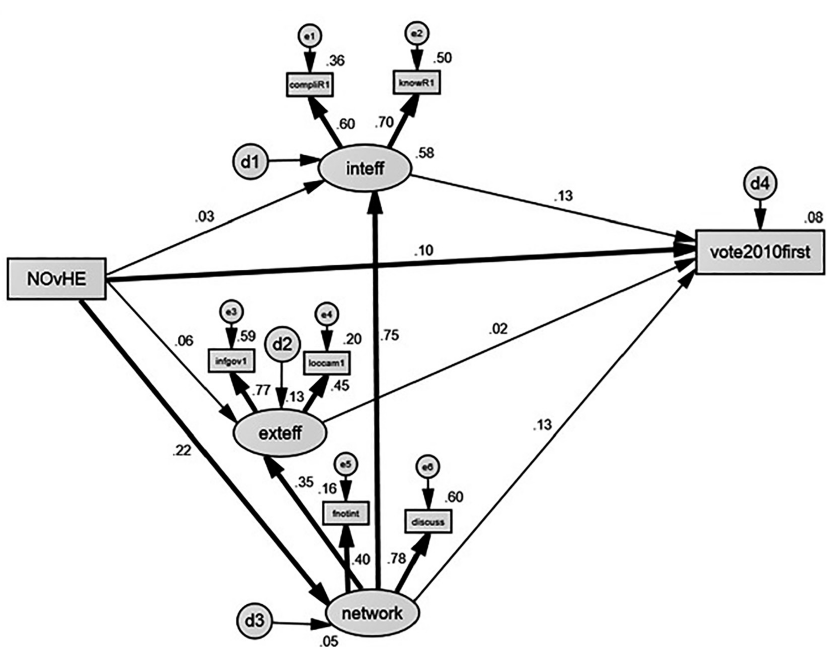
Figure 4: No compulsory schooling versus HE experience and 2010 turnout (standardised results); Chi-square 276.012 (13 d.f.), p=.000, RMSEA =.051, CFI =.958. Source: 2011 CITS (Online responses),